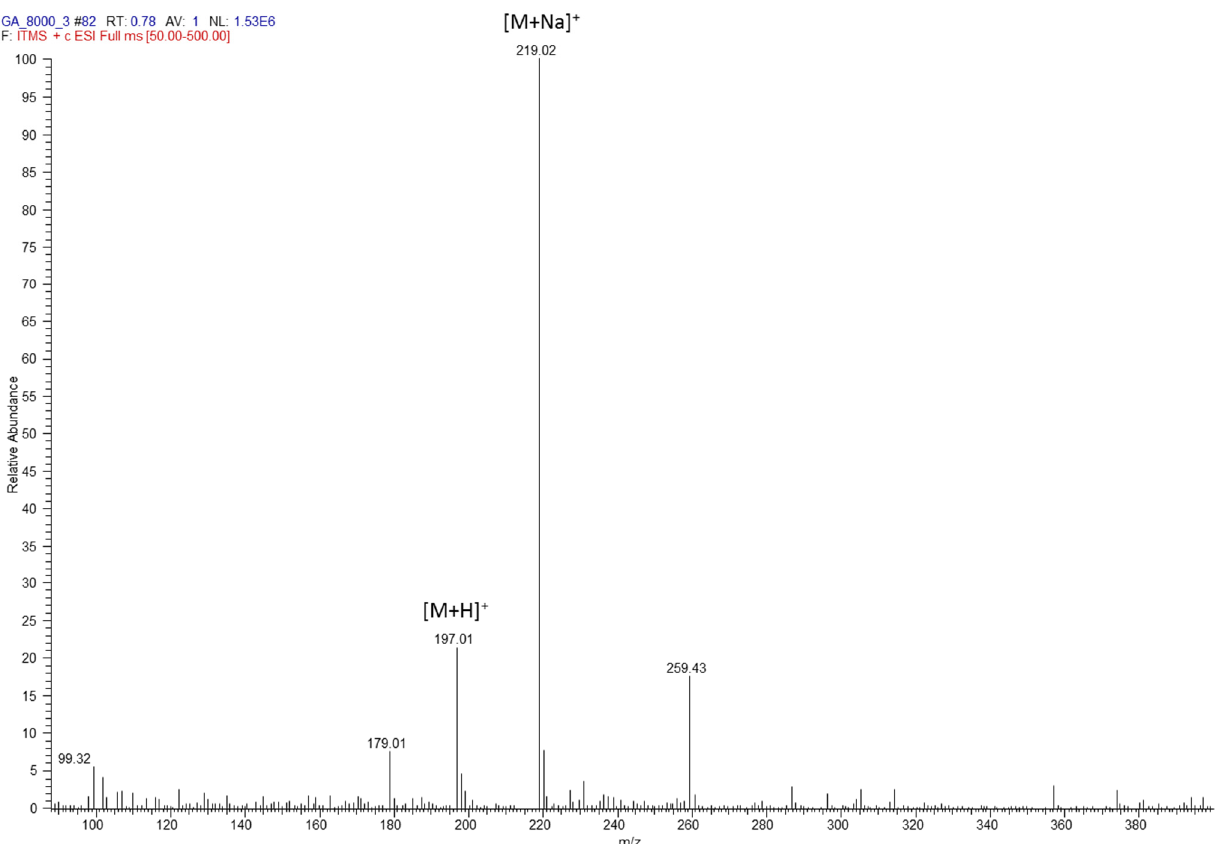
Figure 2. ESI mass spectrum of gluconic acid in 1 mg/L in water, 0.1% formic acid acquired by a direct injection of this solution into the LTQ mass spectrometer at a flow rate 20 μ L/min.